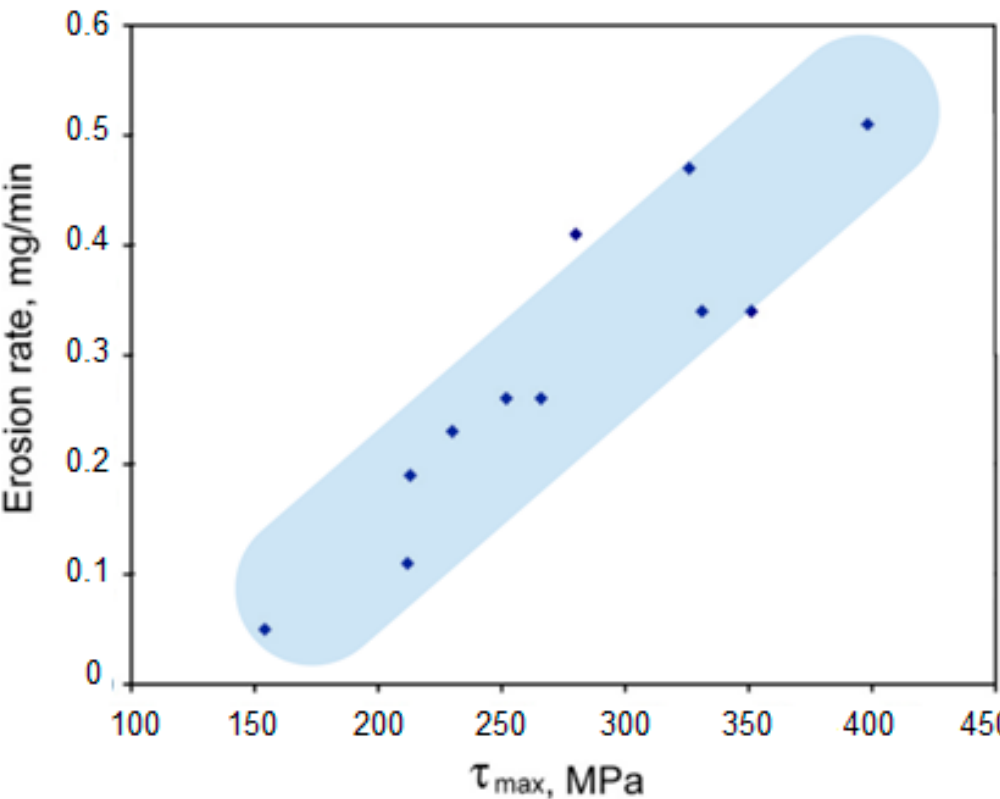
Figure 11. Correlation between erosion rate and maximum shear stress in Ti / TiN and Ti / Ti(V,Zr)N multilayered coatings with thickness from 5 to 20 μ m deposited on Ti-6Al-4V alloy by the Arc-PVD method, reprinted from Wear , Reference [22], with permission from Elsevier.